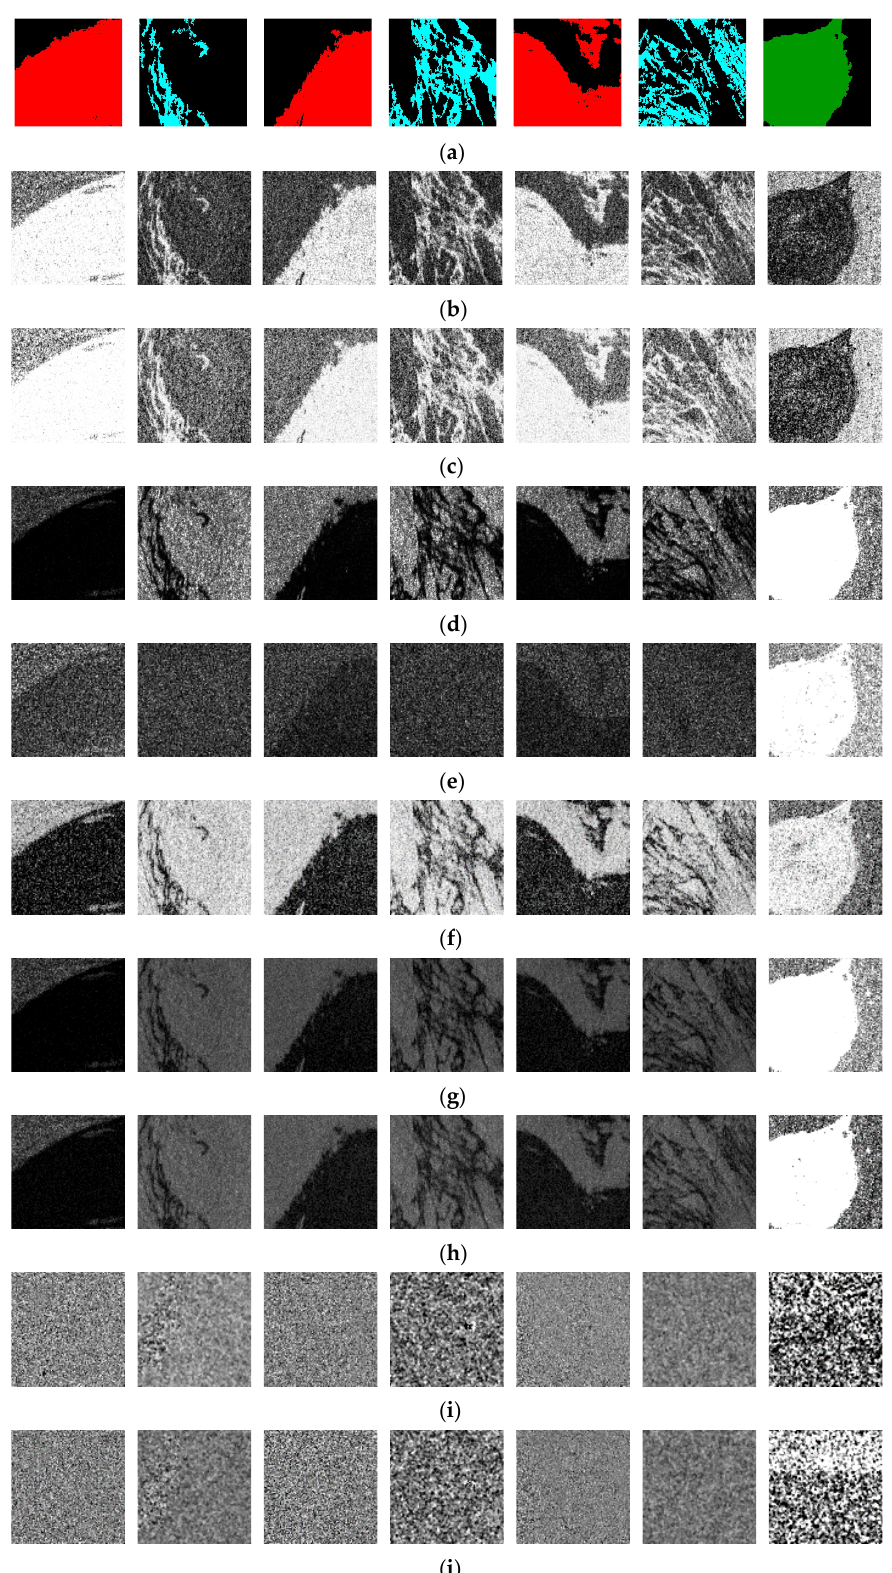
Figure 7. The ground truth and polarized parameter extraction results of the samples used in the experiment. In the ground truth, red represents oil spill, blue represents look-alike, and green represents land areas: ( a ) ground truth, ( b ) Alpha , ( c ) H , ( d ) λ 1 , ( e ) λ 2 , ( f ) Stokes- contrast , ( g ) Stokes- g 0 , ( h ) Stokes- g 1 , ( i ) Stokes- g 2 , and ( j ) Stokes- g 3